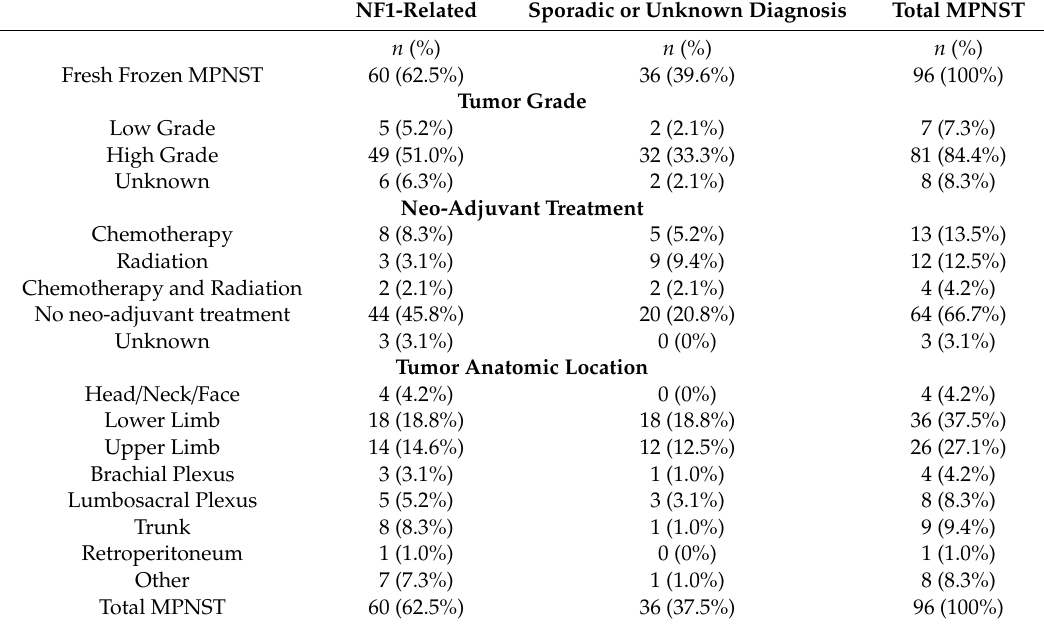
Table 1. Clinical Variables of Fresh Frozen MPNST Collected by GeM